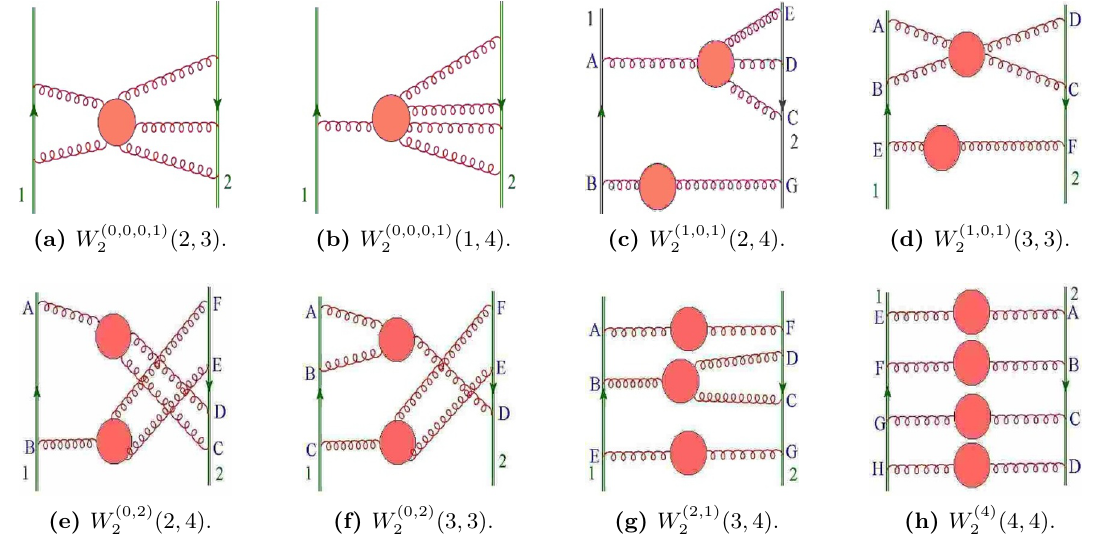
Figure 3. Representative skeleton diagrams for the eight four-loop Cwebs connecting two Wil- son lines in a massless